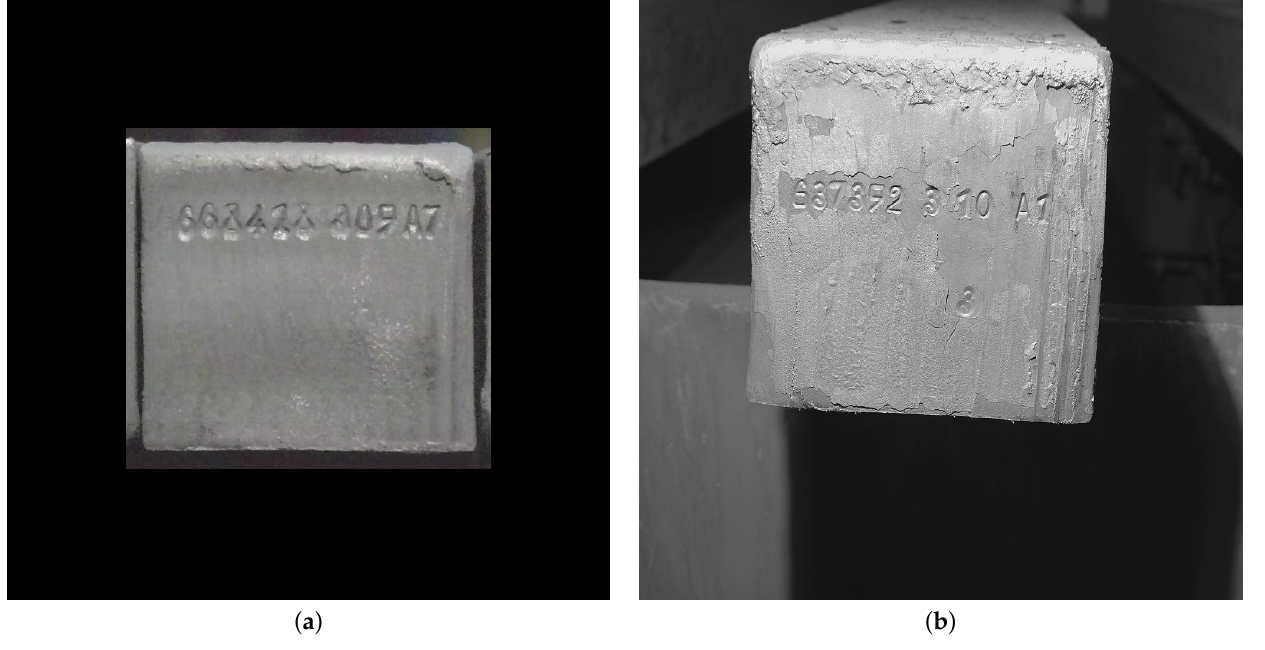
Figure 7. Billet images captured at production sites A ( a ) and B ( b ). About 2 of the real-life training data stem from production site B and about 1 3